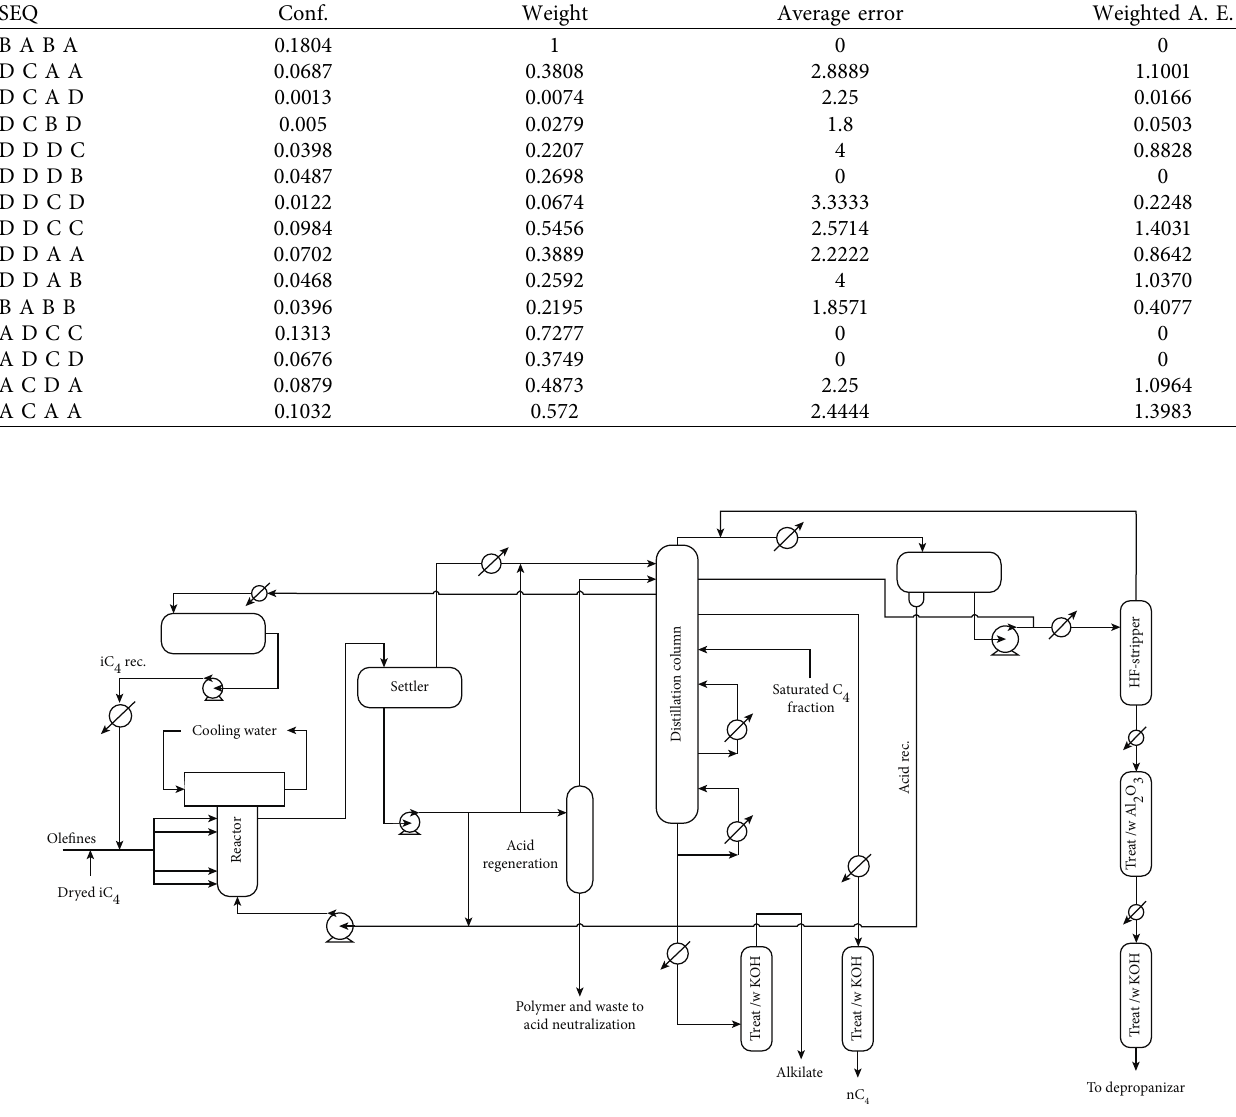
Table 2: Prediction error statistics with every possible Φ